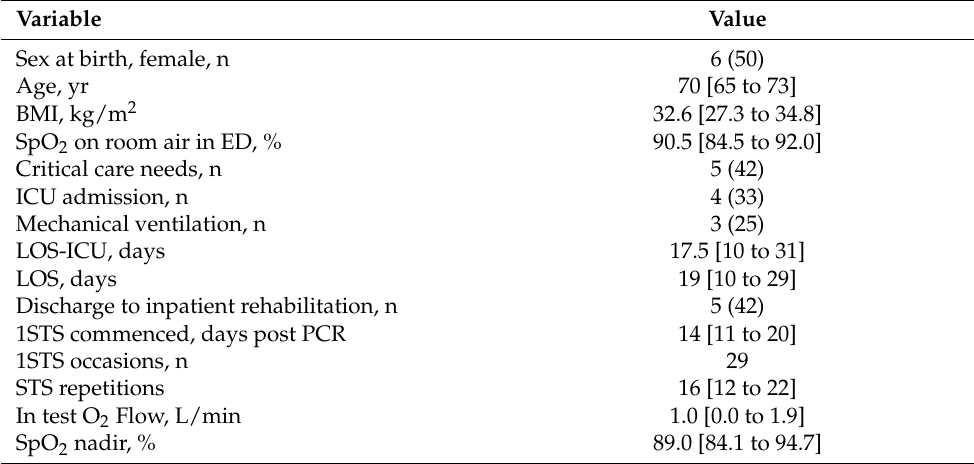
Table 4. Characteristics * of the participants in the COVID+ group who completed repeated 1 min sit to stand (1STS) during acute hospital admission (n =